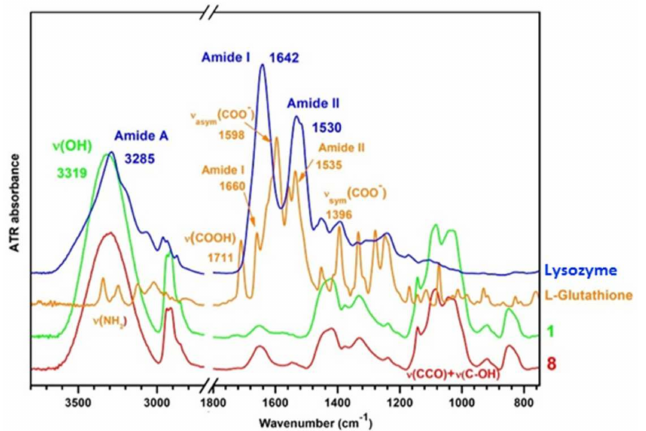
Figure 4. FTIR spectra of PULL/PVA in absence and presence of lysozyme, compared with those of pure lysozyme and GSH.